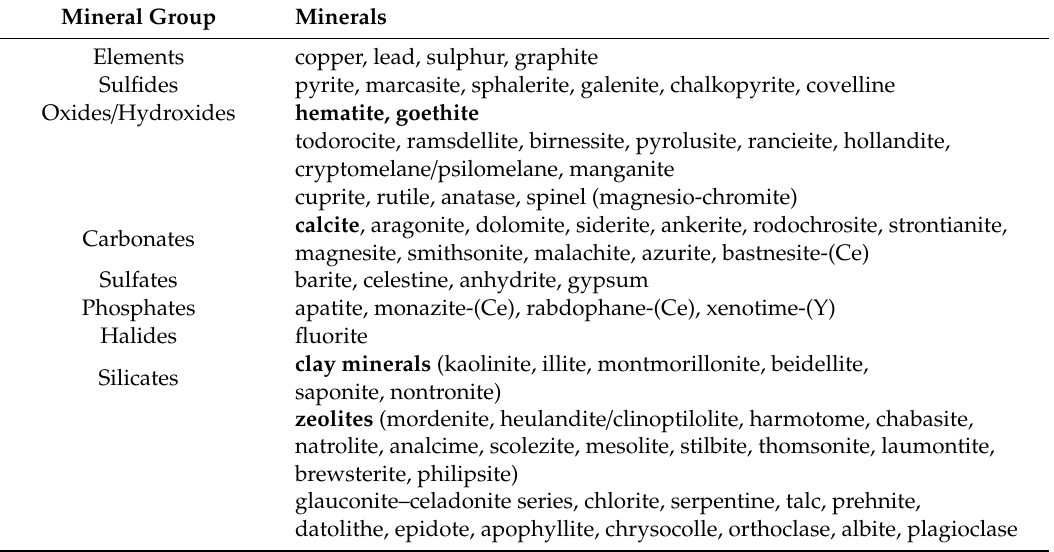
Table 4. Compilation of detected minerals in agates (unpublished data and data from [1,15,18,22,24,28,30,31,34,35,38,42,44–47,49,52–55,59,60,76,78,157–165]); minerals and